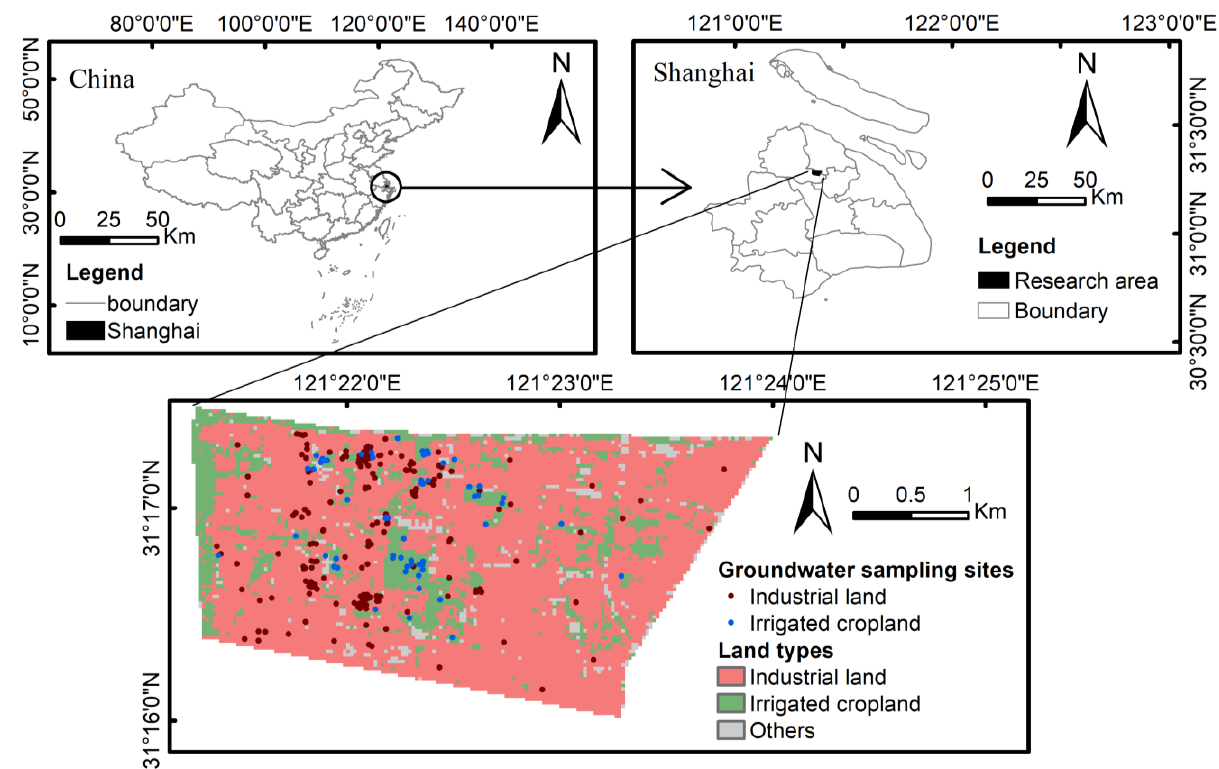
Figure 1. Sketch map of the study site.